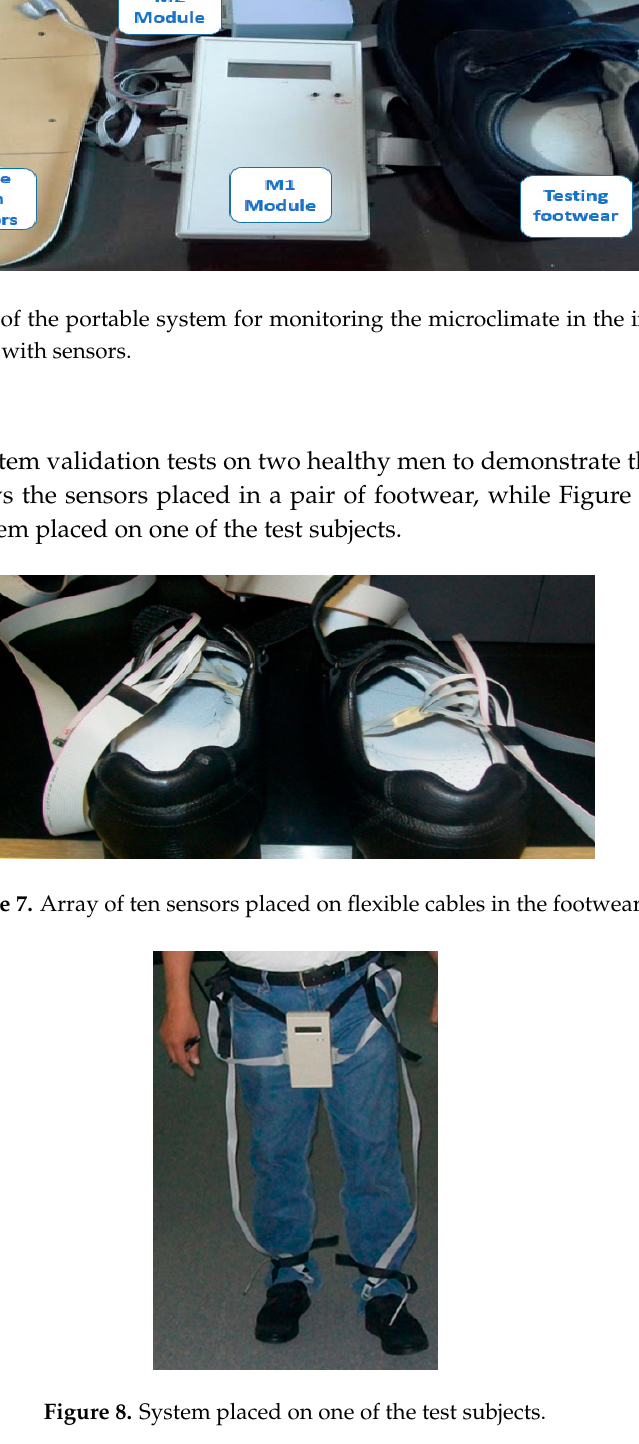
Figure 8. System placed on one of the test subjects.